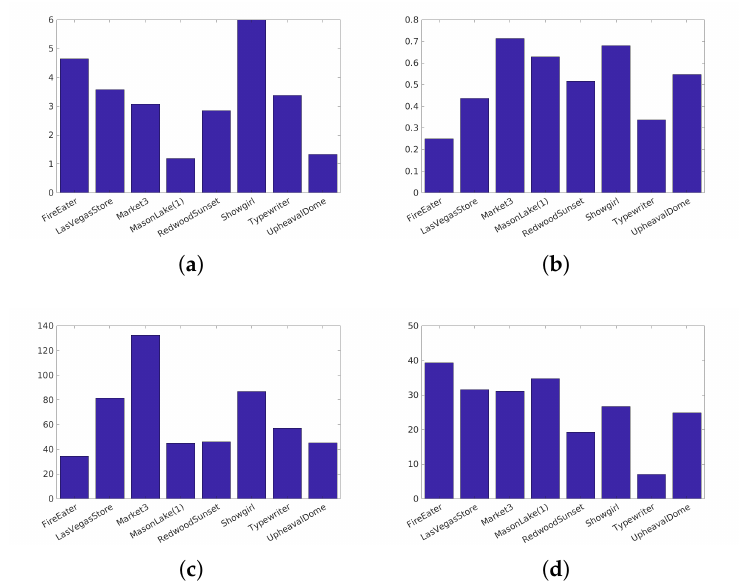
Figure 6. Characteristics of the HDdtb images: ( a ) The dynamic range, ( b ) key, ( c ) spatial Information, ( d )